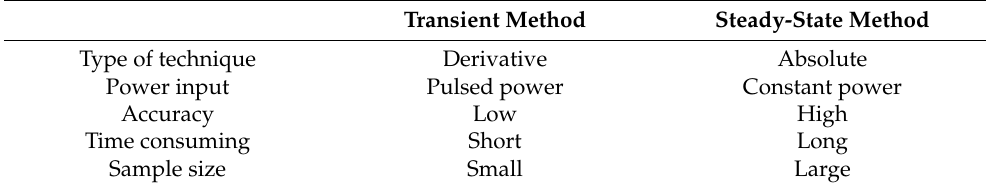
Table 1. Main characteristics of transient and steady-state techniques in relation to the measurement of insulating materials.